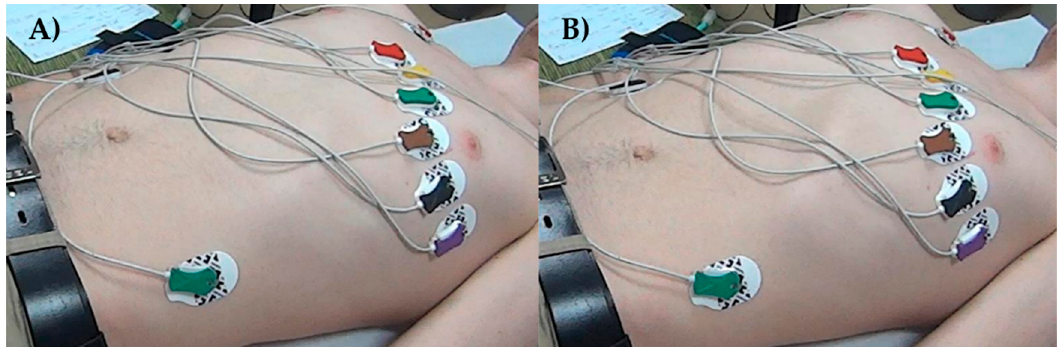
Figure 1. Picture from one of the videos, showing the athlete lying down: ( A ) end of inspiratory phase, ( B ) end of expiratory phase.